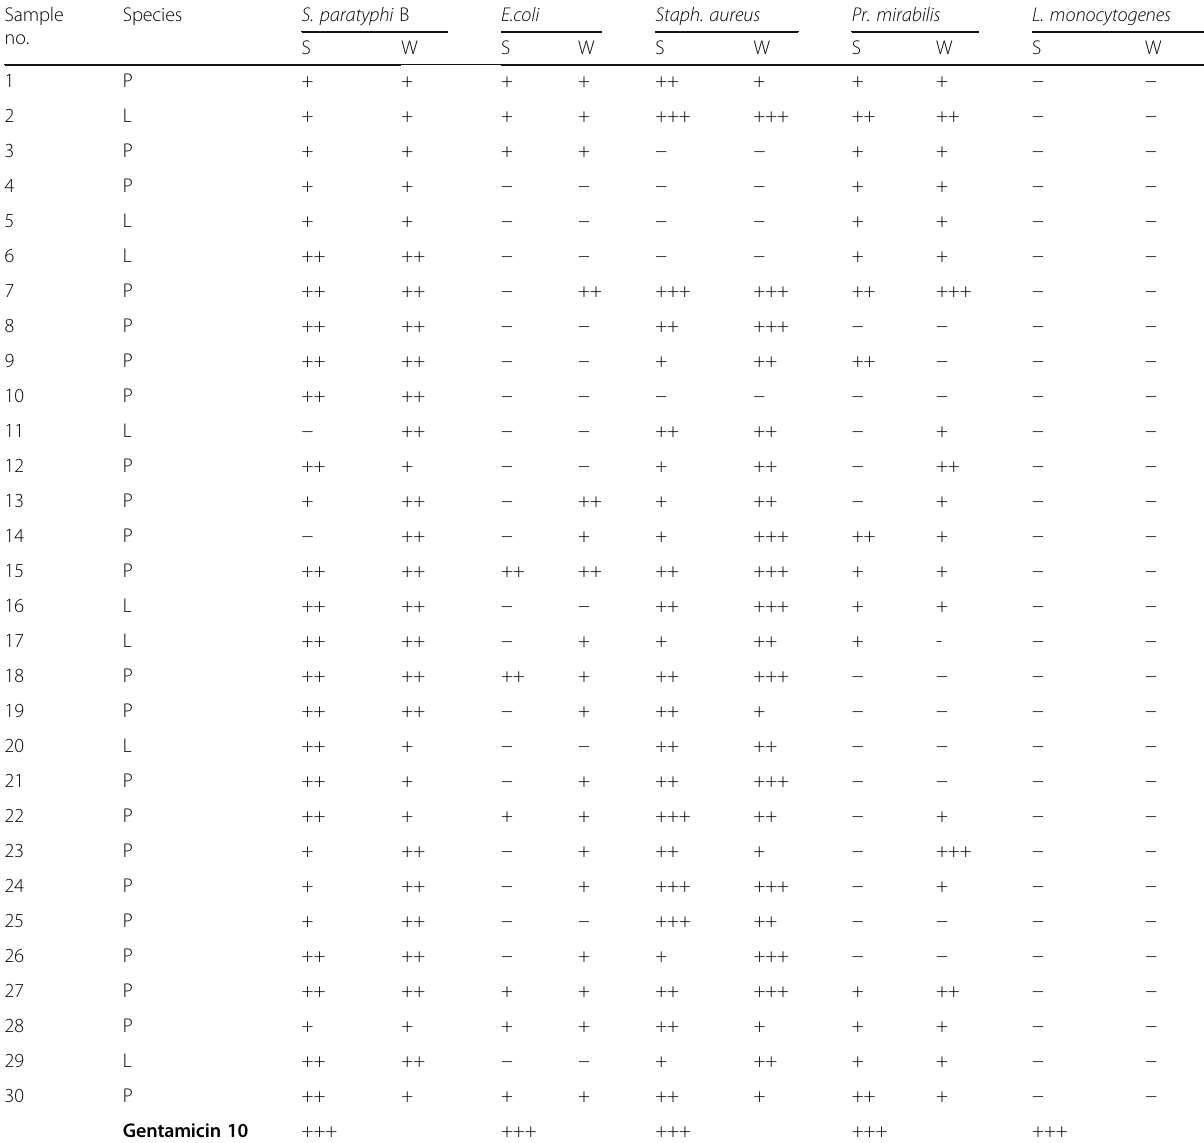
Table 3 Antibacterial activity of isolated lactic acid bacterial strains by diffusion test and well diffusion test Sample